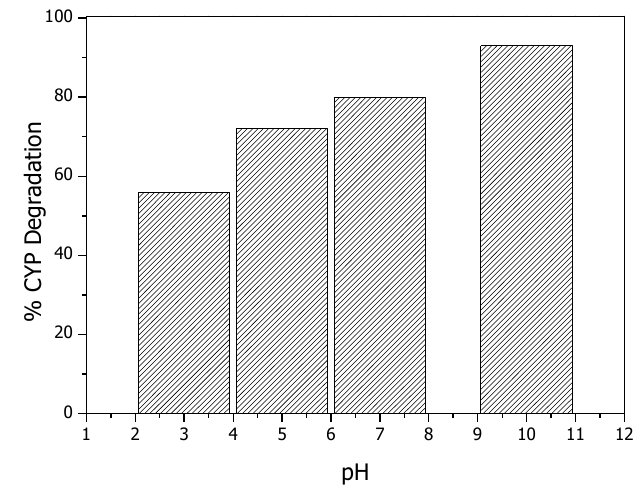
Figure 5. The concentration of OH · produced during ozonation and catalytic ozonation. In catalytic ozonation experiments, solution pH effects the surface properties of the catalyst and further determines the catalytic activity. Extensive studies suggest that in the metal-based catalysts, the surface hydroxyl groups acts as catalytic active sites for the decomposition of O 3 . To better understand the mechanism of ROS production by Mg (OH) 2 /O 3 , catalytic ozonation experiments with pH values ranging from 3 to 7 were conducted. Due to the electrophilic properties of O 3 , surface hydroxyl groups on Mg(OH) 2 act as catalytic active sites for the transformation of O 3 to OH · [23]. Figure 6 shows that basic pH favors the degradation of CYP. As pH increases from 7 to 10, more hydroxyl groups will form on the surface of the catalyst, thereby enhancing the absorption and decomposition of O 3 to OH as shown in Equations (4) and (5). As shown in Equations (4) and (5), Mg(OH) 2 acts as an initiator in the process. O 3 adsorbed on the surface of Mg(OH) 2 and reacted with surface hydroxyl groups leading to the formation of Mg–OH O ˙ as the first step; then Mg–OH O ˙ was attacked by ozone producing OH · radicals [25,26]. These results suggest that surface hydroxyl groups on Mg (OH) 2 act as catalytic sites for the decomposition of O 3 .